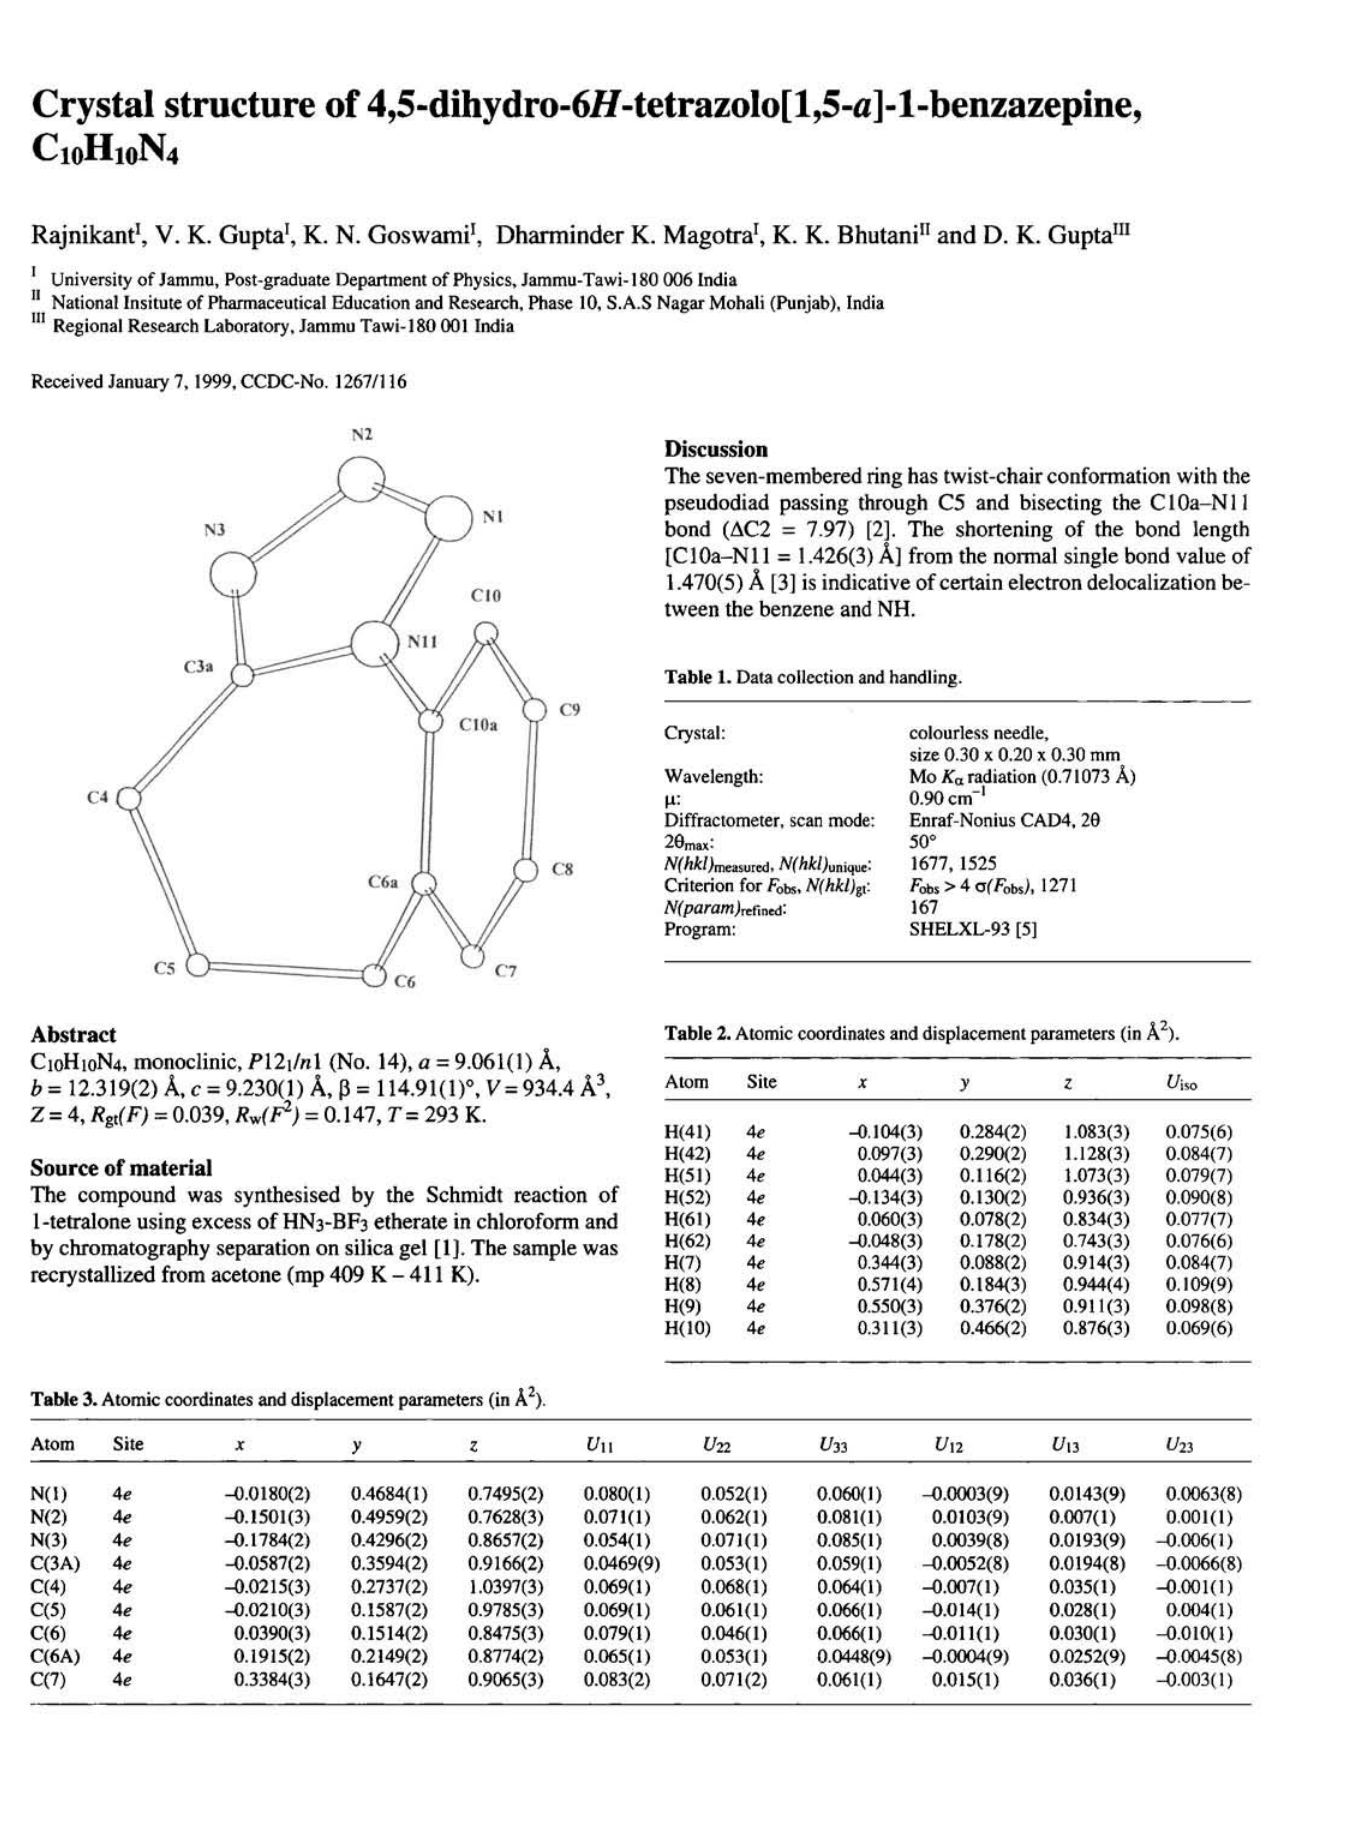
Table 3. Atomic coordinates and displacement parameters (in Â 2